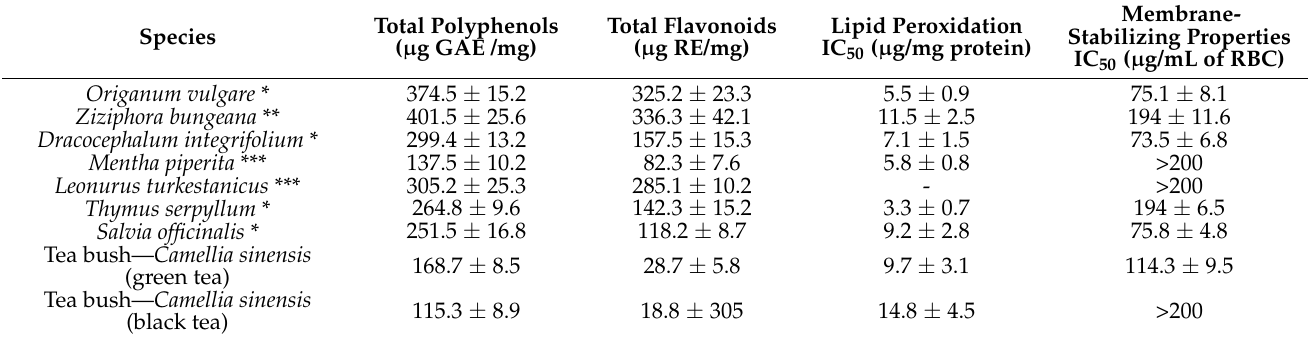
Table 1. Lipid peroxidation and membrane-stabilizing properties of several Lamiaceae family plant extracts (mean ± standard deviation (SD), n =